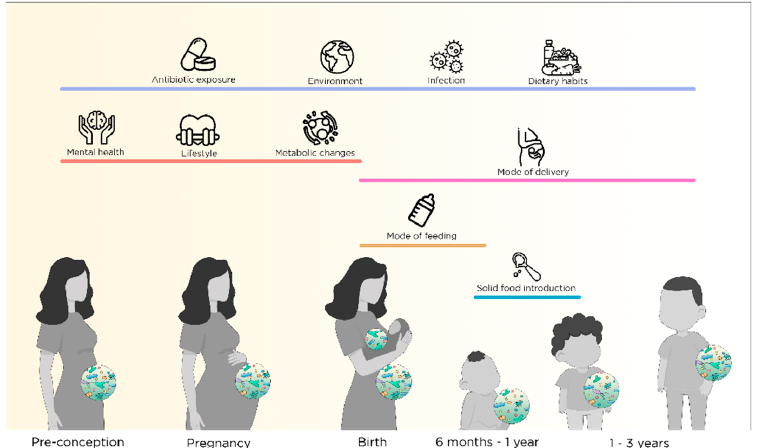
Figure 1. Early life factors influencing cognitive and microbial development of the child from preconception throughout the first 3 years of life; maternal mental health, lifestyle and metabolic changes affect fetal development. Antibiotic use, infections, environment, dietary habits and mode of delivery impacts the maternal health status, the fetal development during pregnancy and the microbiota and cognitive development of children from birth to at least 3 years. Mode of feeding in early life and solid food introduction influence the microbial and cognitive development of the offspring from birth up to at least 3 years of age.